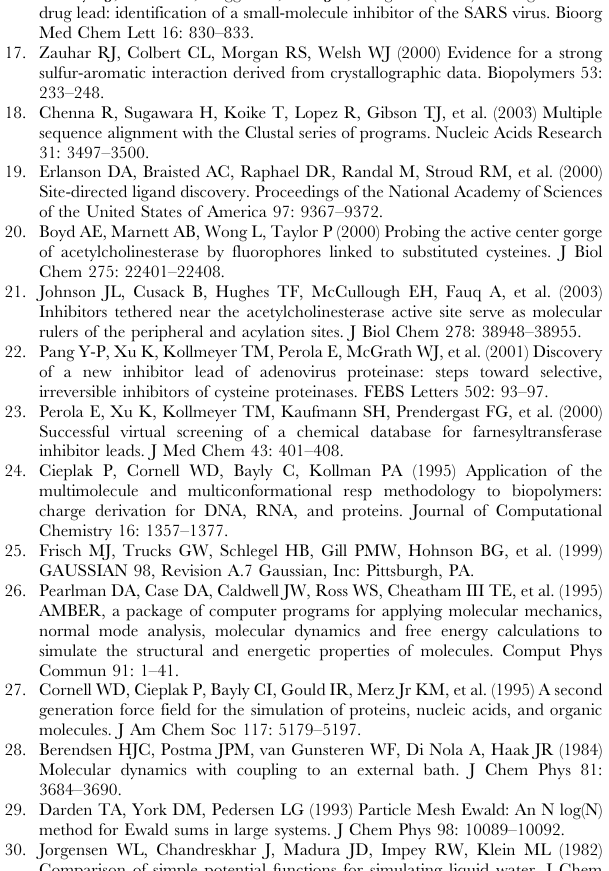
Figure S1 The SwissModel-generated multiple sequence align- ments and the secondary structure prediction of Anopheles gambiae acetylcholinesterase. GenBank ID of the A. gambiae acetylcholin- esterase sequence: BN000066; Protein Data Bank IDs of mouse acetylcholinesterase structures: 1J07 and 1N5R; Protein Data Bank ID of the electric eel acetylcholinesterase structure: 1C2O. The A. gambiae -specific residues (C286 and R339) are colored in red. Figure S2 Multiple sequence alignments of acetylcholinesterases of the 73 species listed in Table 1. The alignments were generated